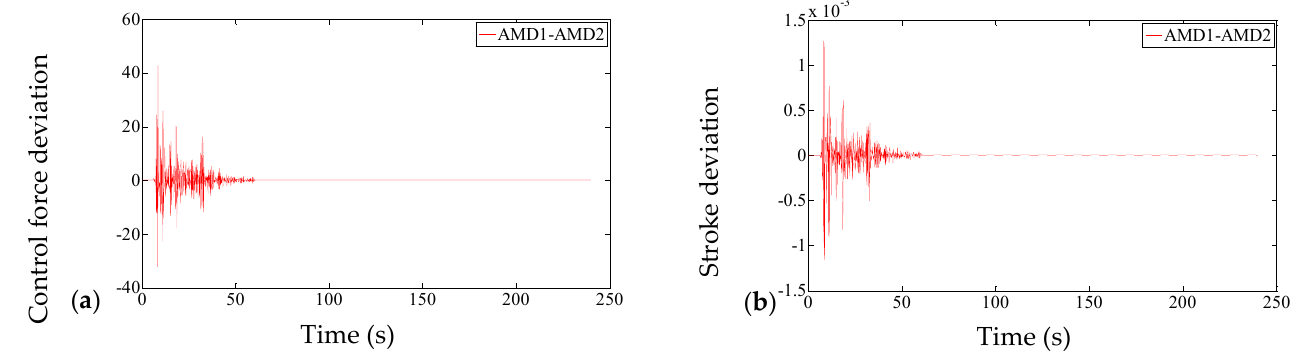
Figure 8. The deviations to the control parameters of System2 with unequal time delays, ( a ) the forces and ( b ) the strokes.